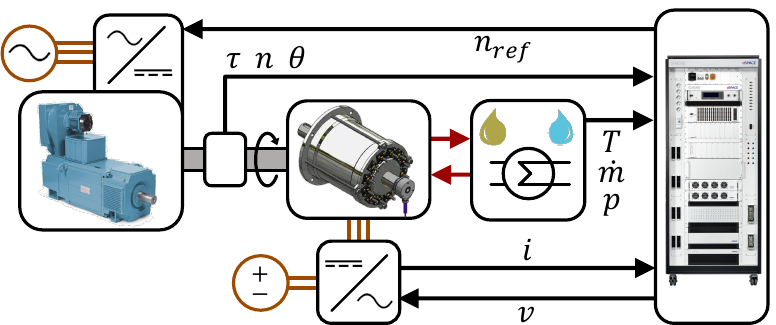
Figure 10. Calorimetric measurement system setup: A dSpace system is controlling the dynamo, the prototype machine, and the custom made oil-to-water cooling